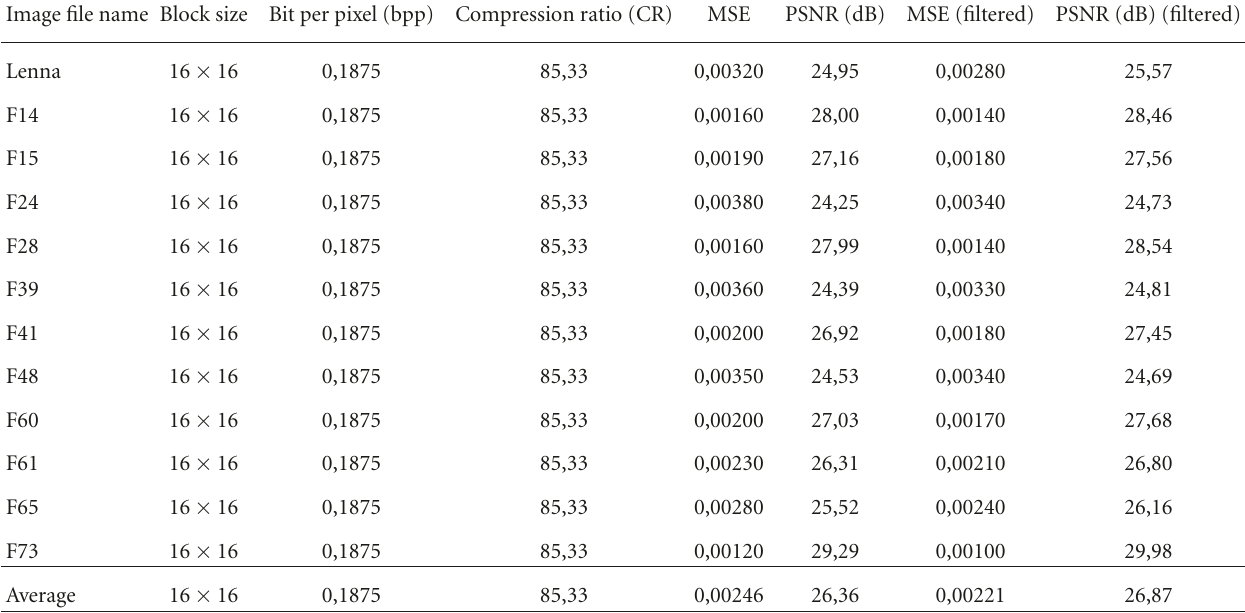
Table 11: Evaluation results of the second group of experiments (with